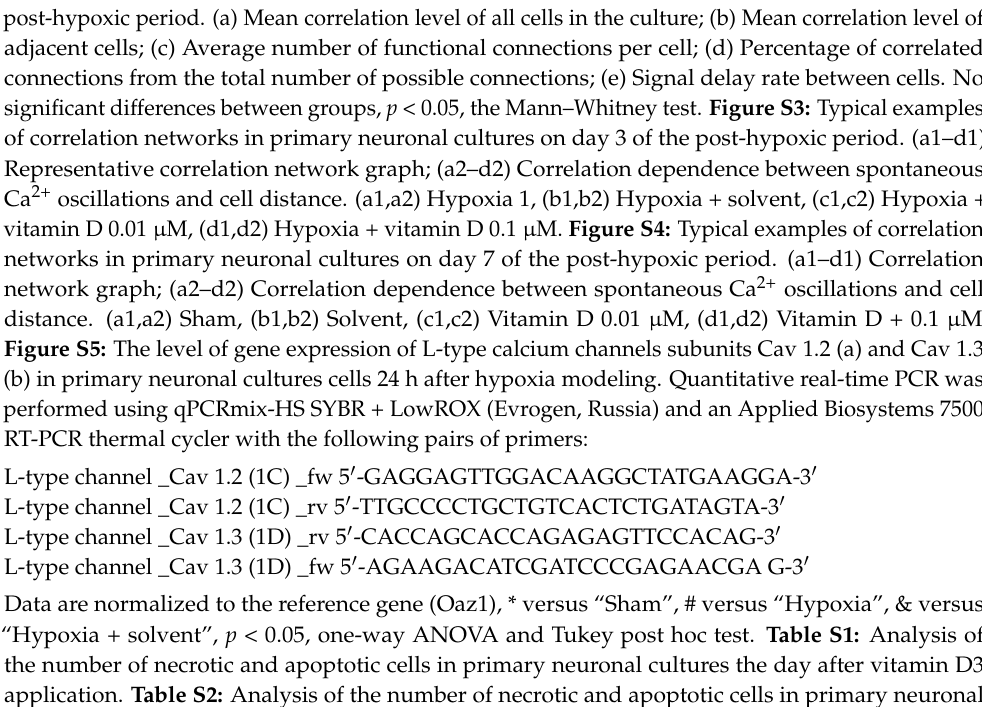
application. Table S2: Analysis of the number of necrotic and apoptotic cells in primary neuronal cultures day after hypoxia modeling. Videos S1–S9: Representative examples of spontaneous calcium activity recordings in primary neuronal cultures day 7 after vitamin D3 application and hypoxia modeling. S1 Sham; S2 Solvent; S3 Vitamin D3 0.01 µ M; S4 Vitamin D3 0.1 µ M; S5 Vitamin D3 1 µ M; S6 Hypoxia; S7 Hypoxia + solvent; S8 Hypoxia + Vitamin D3 0.01 µ M; S9 Hypoxia